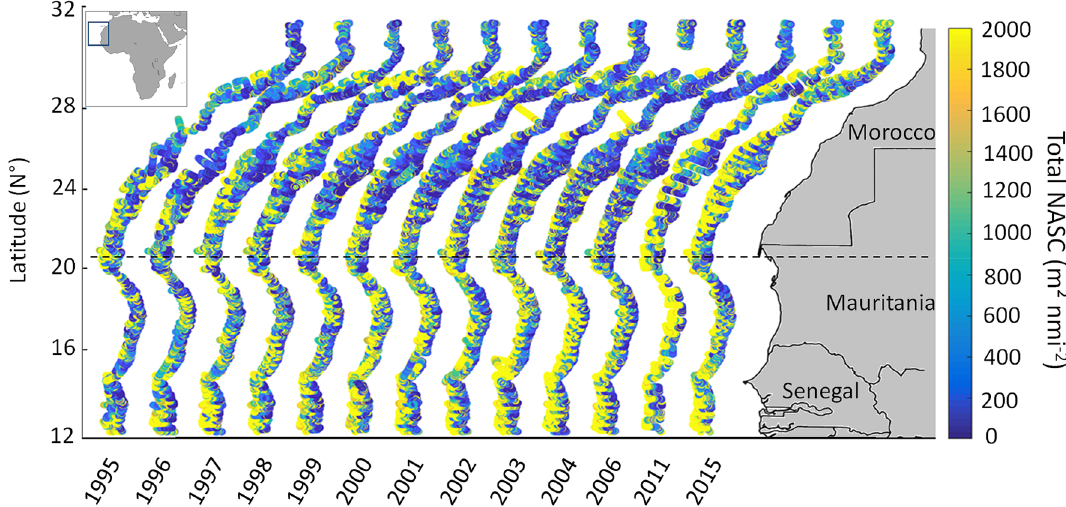
Figure 1. Study area was limited to the continental shelf of the south part of the Canary Current Large Marine Ecosystem. The dashed line represent the Cap Blanc limit dividing the study area into two part. We conductedpelagic acoustic sea survey on the same vessel and used the same protocol to process the total acoustic density of the Nautical Area Scattering Coefficient (NASC, m 2 nmi −2 ) from 1995 to 2015, as a proxy of pelagic abundance. The map was performed with Matlab R 2018a 20 (https ://fr.mathw orks.com/produ cts/new_produ cts/ relea se201 8a.html).